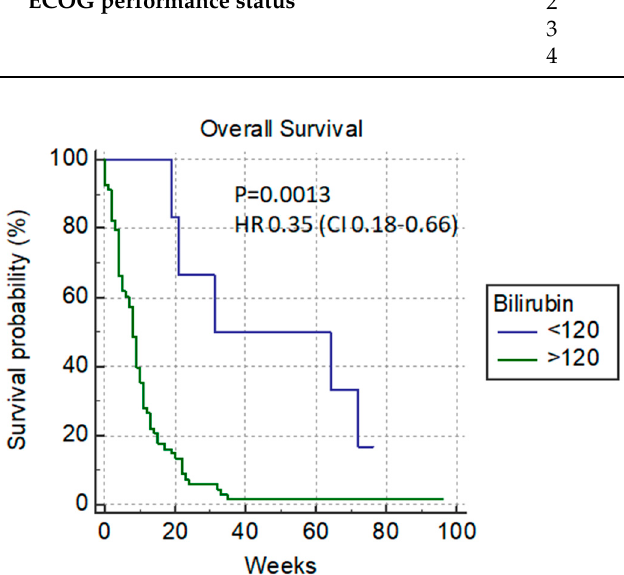
Figure 1. Normalized-bilirubin-level patients after PTBD.